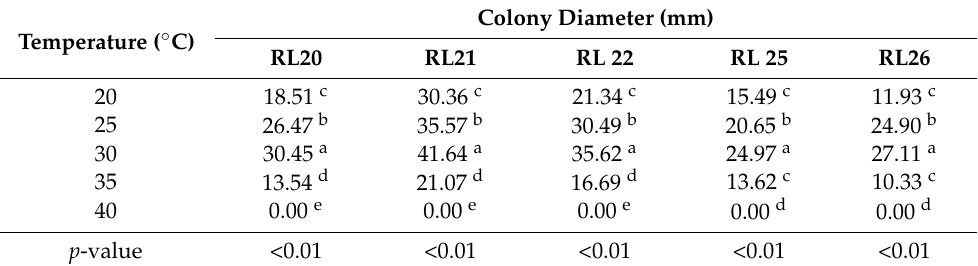
Table 6. Average colony diameters of all five isolates of R. microporus after 3 days of incubation under different temperature. Temperature ( ◦ C)